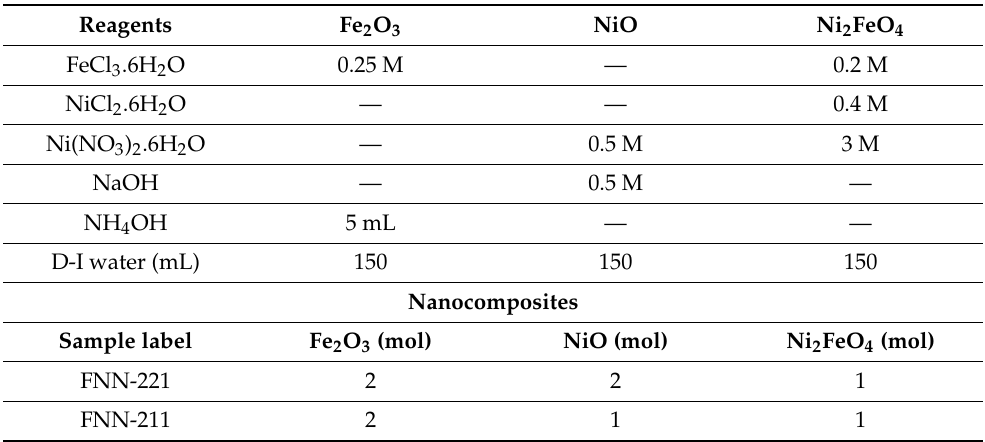
Table 1. Amount reagents and solutions taken during the synthesis process; ratio of individual component taken in each